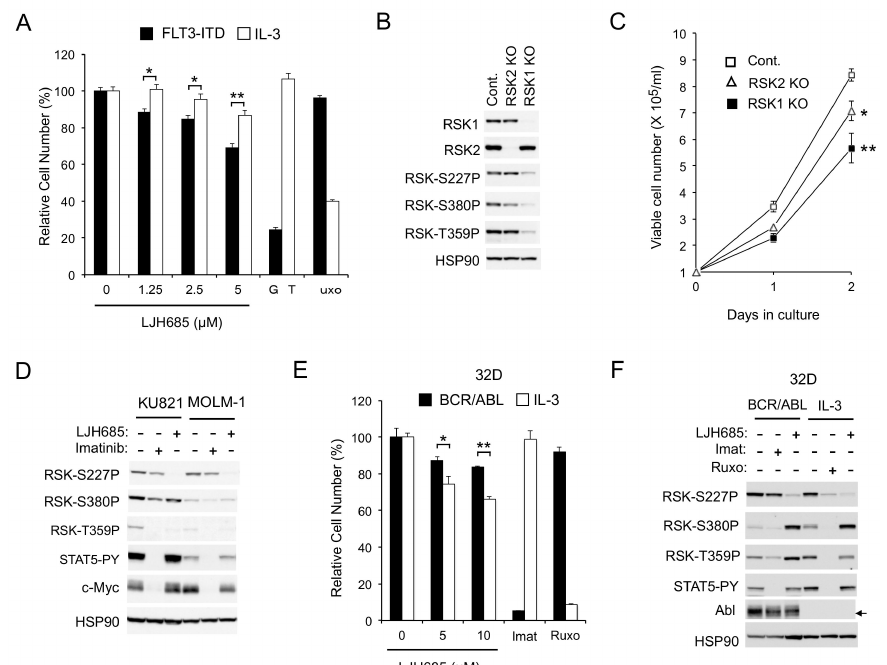
Figure 2. RSKs play a crucial role in proliferation of cells transformed by FLT3-ITD but not BCR / ABL. ( A ) 32D / FLT3-ITD cells inducibly expressing FLT3-ITD (FLT3-ITD) and cultured without IL3 or cultured with IL3 (IL3) without expressing FLT3-ITD were cultured for 48 h with indicated concentrations of LJH685, 50 nM gilteritinib (GRT), or 2 µ M ruxolitinib (Ruxo), as indicated, and subjected to the colorimetric assay. Each column represents the mean of triplicate cultures, with error bars indicating standard errors, and is expressed as a percentage to the control cell numbers. The asterisks indicate statistically significant di ff erences from control cells determined by Student’s t -test (* p < 0.05, ** p < 0.01). ( B ) MV4-11 cells knocked out (KO) of RSK1 or RSK2, as well as vector control cells (Cont.), as indicated, were subjected to immunoblot analysis. Abbreviations: RSK-S227P, phospho-S227-RSK2; RSK-S380P, phospho-S380-RSK1; RSK-T359P, phospho-T359 / S363-RSK1. ( C ) MV4-11 cells knocked out (KO) of RSK1 or RSK2, as well as vector control cells (Cont.), as indicated, were cultured for indicated days, and viable cell numbers were counted and plotted. Each data point represents the mean of triplicate determinations, with error bars indicating standard errors. * p < 0.05, ** p < 0.005. ( D ) KU821 or MOLM-1 cells were treated for 6 h with 2 µ M imatinib or 5 µ M LJH685, as indicated, and analyzed. STAT5-PY: Phospho-Y694-STAT5. ( E ) 32D cells expressing BCR / ABL (BCR / ABL) and cultured without IL-3 or parental 32D cells cultured with IL-3 (IL-3) were cultured for 48 h with indicated concentrations of LJH685, 1 µ M imatinib (Imat), or 1 mM ruxolitinib (Ruxo), as indicated, and analyzed. * p = 0.054, ** p < 0.0005. ( F ) 32D cells described in ( E ) were treated for 6 h with 5 µ M LJH685, 3 µ M imatinib, or 3 µ M ruxolitinib, as indicated, and